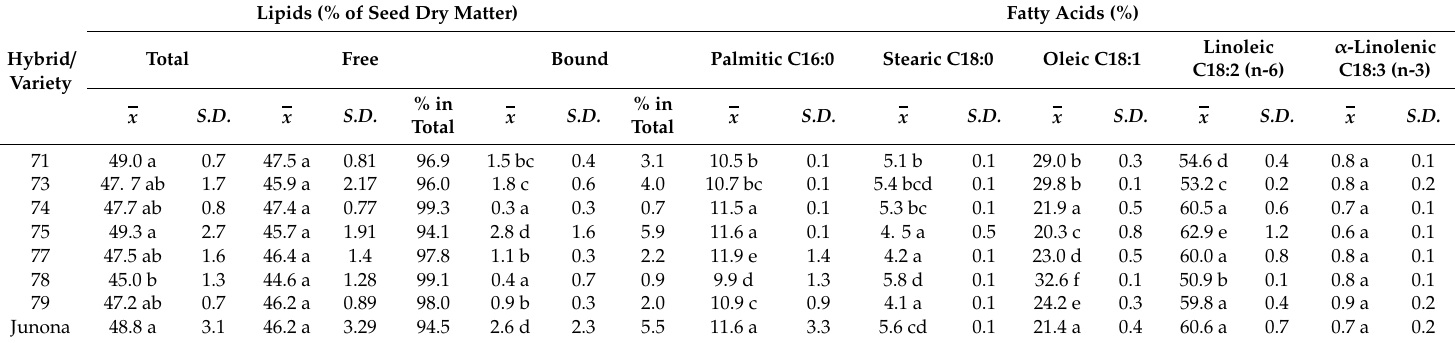
Table 1. Lipid content and fatty acid composition of total fat from seeds of studied Styrian oil pumpkins.